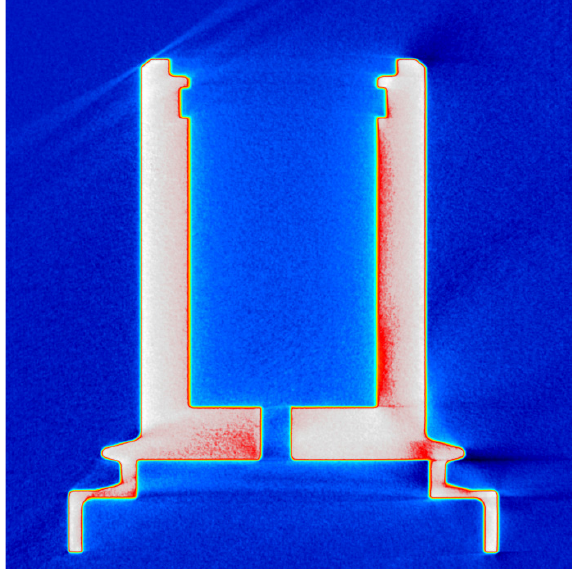
Fig. 4. Reconstruction slice of the pipe connector showing im- age artifacts at the top (object at the borders of the detector), and at the bottom (big length of the X-rays traveling through the aluminum matter).